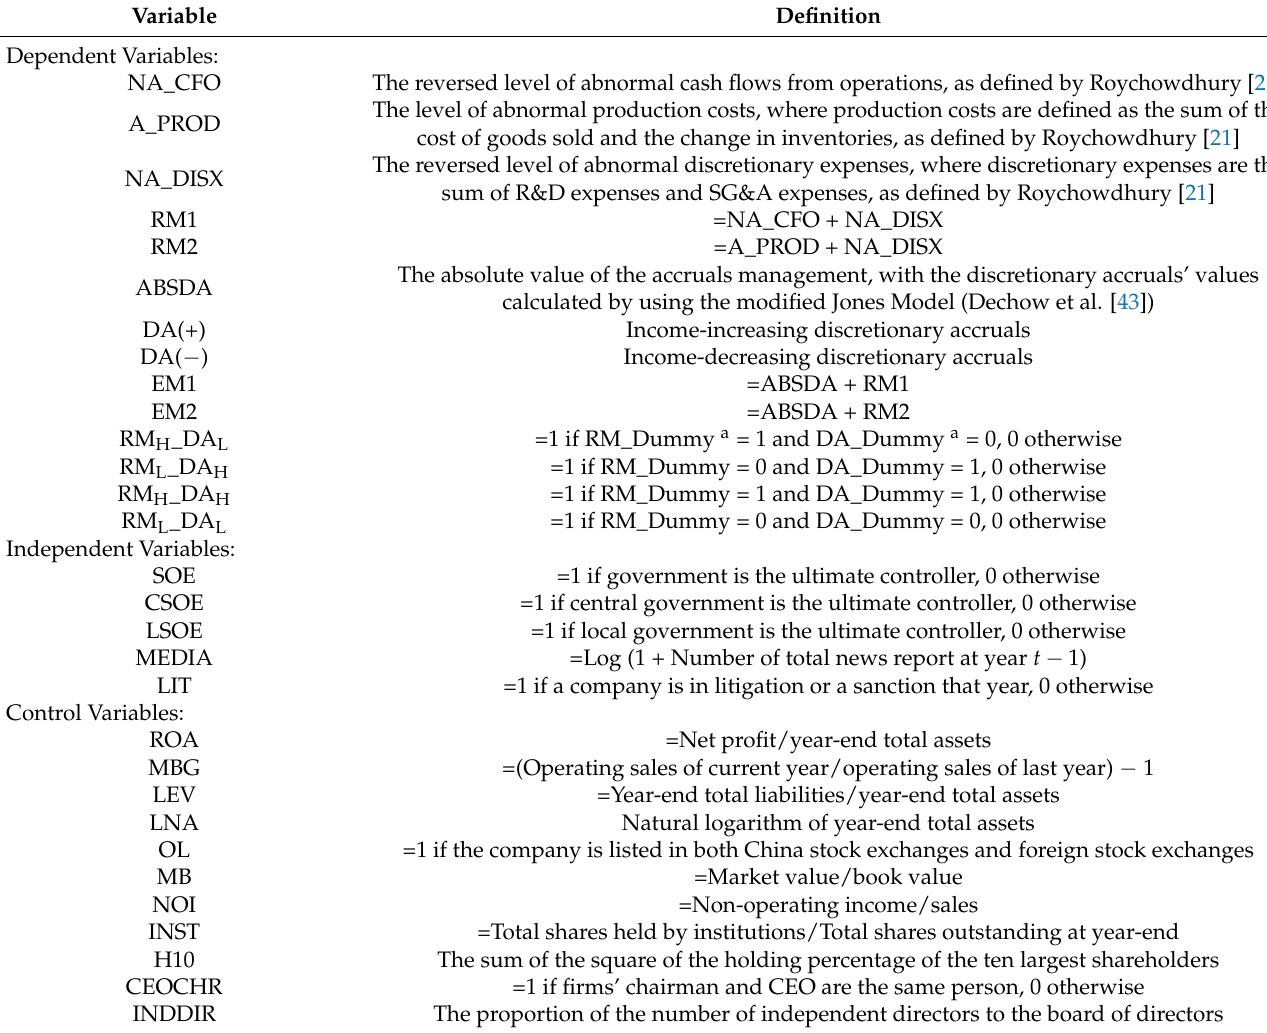
Table 2. Definition of